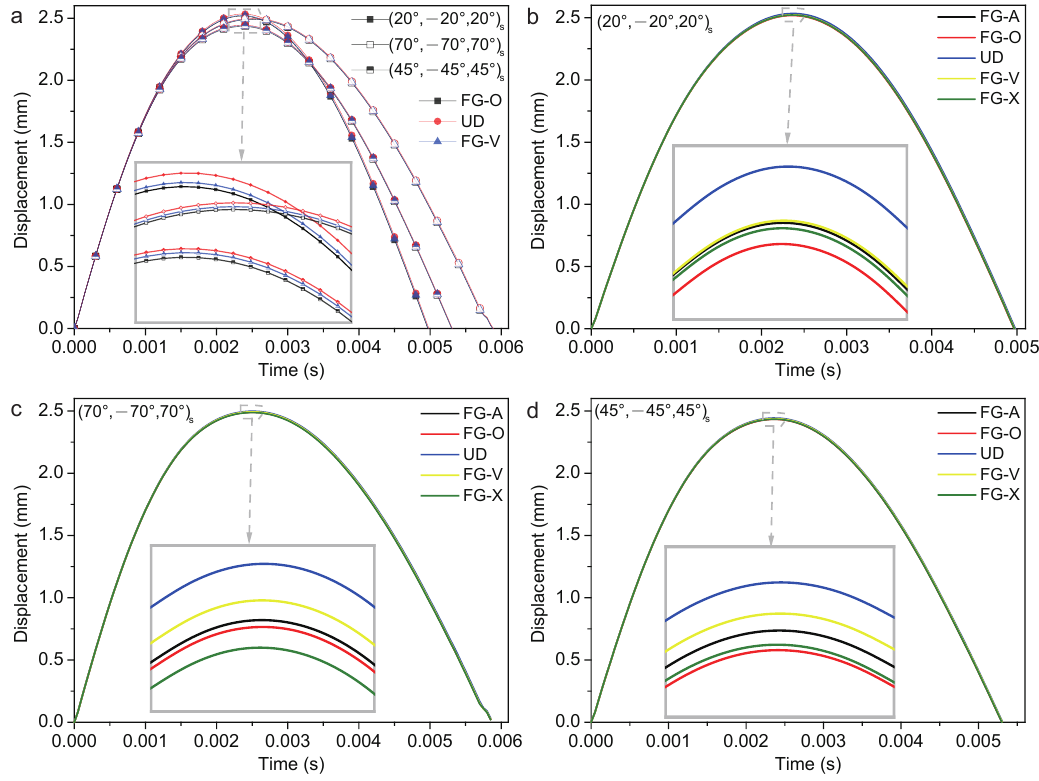
Figure 8. Plate center displacement response of a sandwich structure with various gradient forms: ( a ) FG-O, UD and FG-V face sheets plate; ( b ) (20/ − 20/20)s plate; ( c ) (70/ − 70/70)s plate; and ( d ) (45/ − 45/45)s